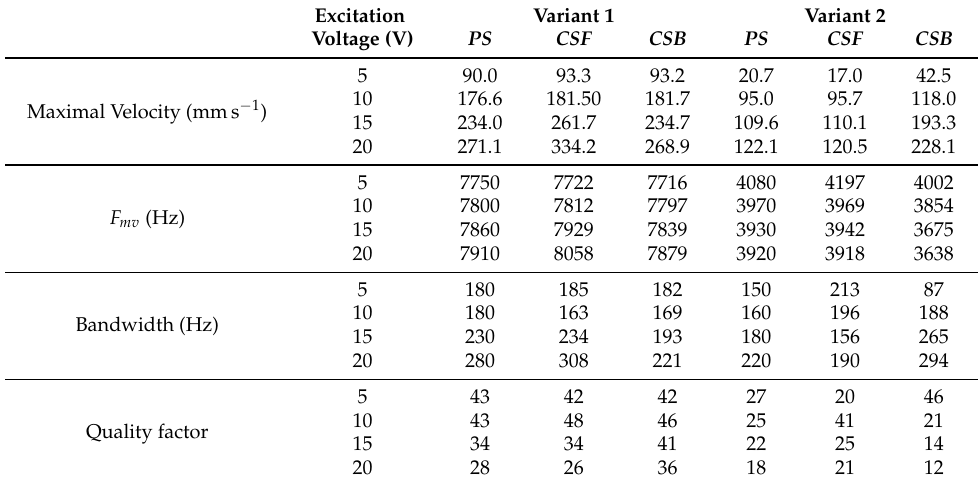
Table 4. Summary of the characteristics of each variant for different excitation signal types.